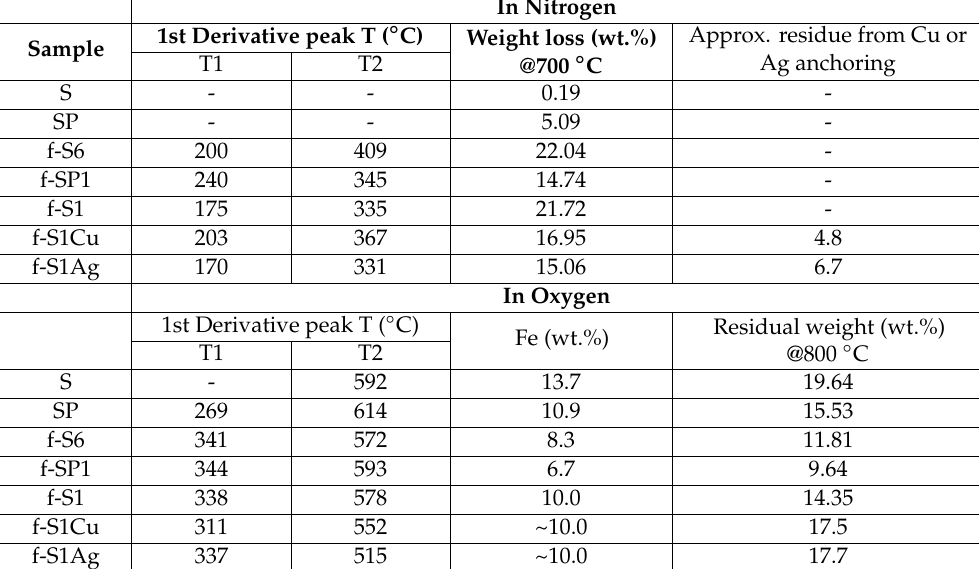
Table 2. TGA results for the analysis performed under nitrogen and under oxygen atmosphere. In